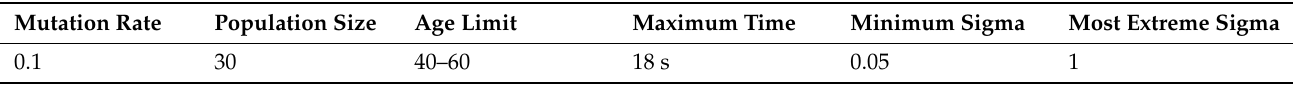
Table 1. Experimental setup.